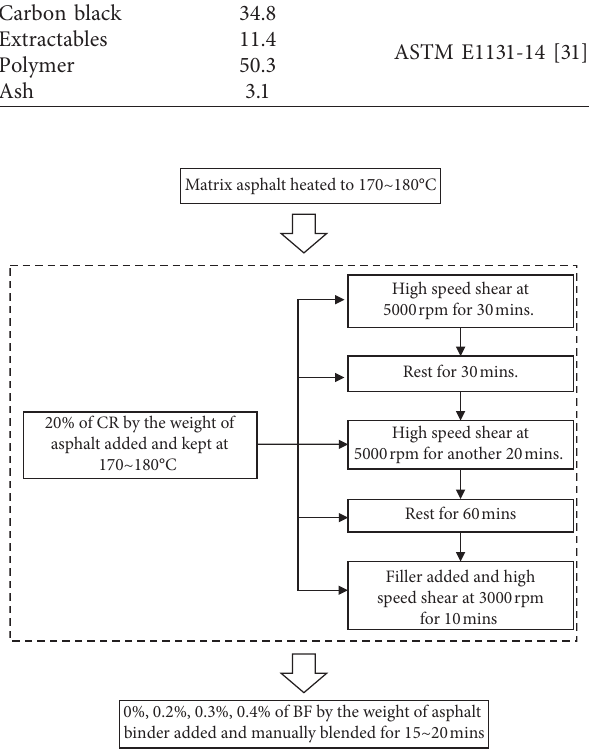
Figure 1: Scheme of CR-BF asphalt binder